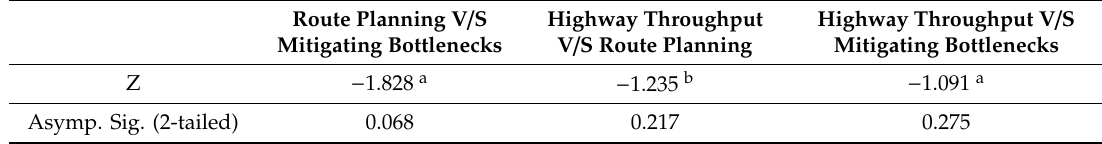
Table 5. Wilcoxon Sign rank test (Statistics) Big